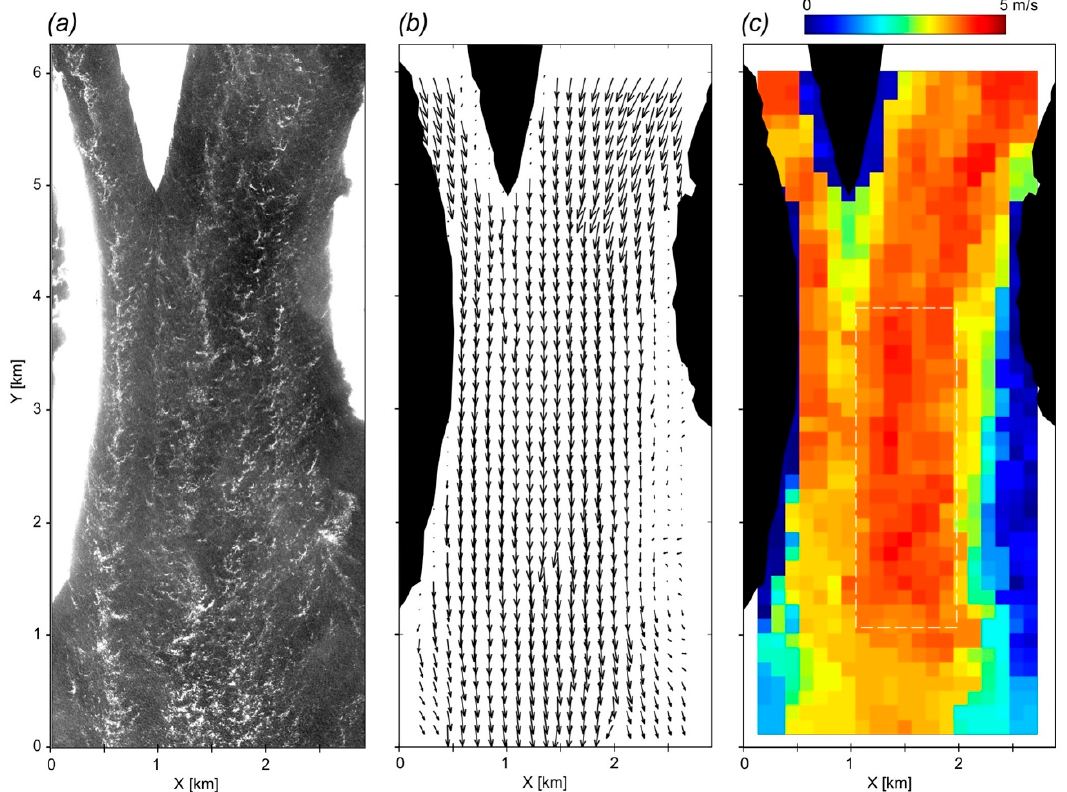
Figure 5. Velocity field at mid-flood as derived from PIV analysis of an image pair (looks 6 and 7) having a time separation of Δ t = t 2 – t 1 = 11.6 s (see Table 1). ( a ) Red-edge imagery at time t 1 ; ( b ) velocity vectors; ( c ) velocity magnitude. Black areas are a land mask. The longest vector in ( b ) has a length of 4.37 m/s. Dashed rectangle in ( c ) shows area used for spatial averaging.